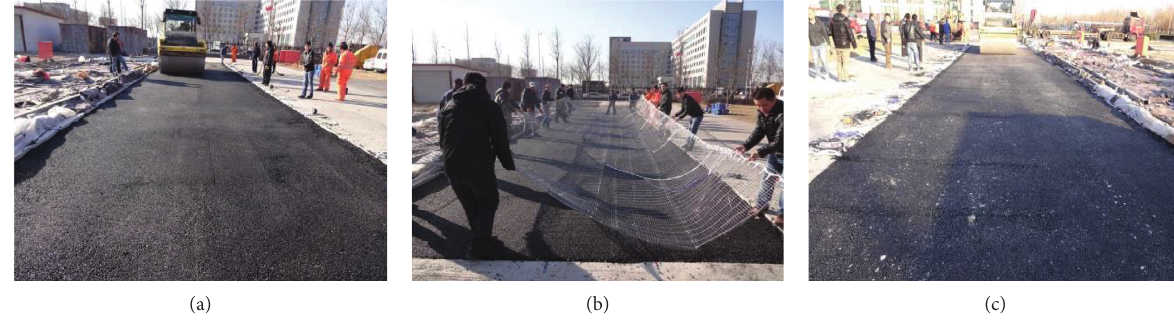
Figure 1: Airport asphalt pavement construction. (a) Lower layer. (b) Heating system layout. (c) Upper layer.